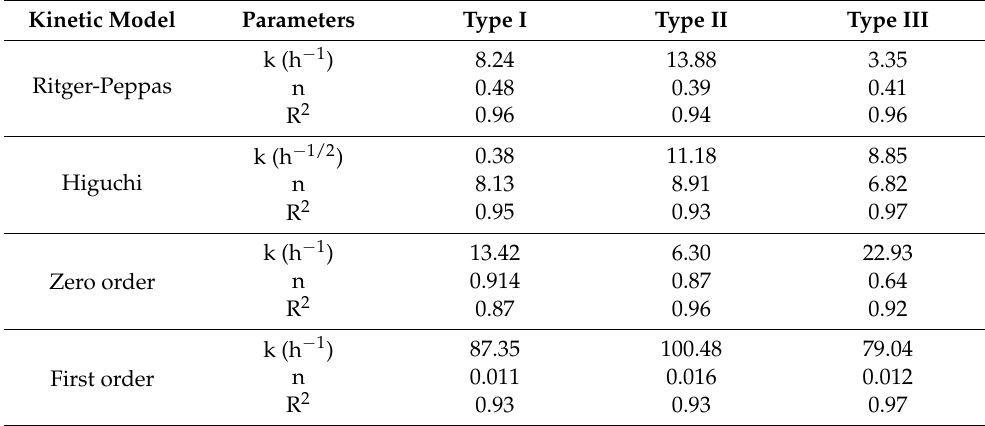
Table 3. Kinetic fitting parameters of the vancomycin release from drug-loaded alginate aerogels in PBS solution (pH 7.4) to different kinetic models. Bold letters highlight the more adequate